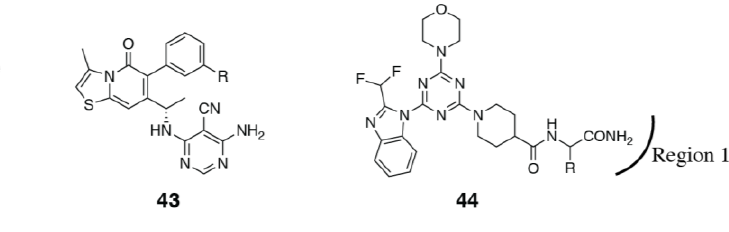
Figure 8. Structures of 42 – 44 .